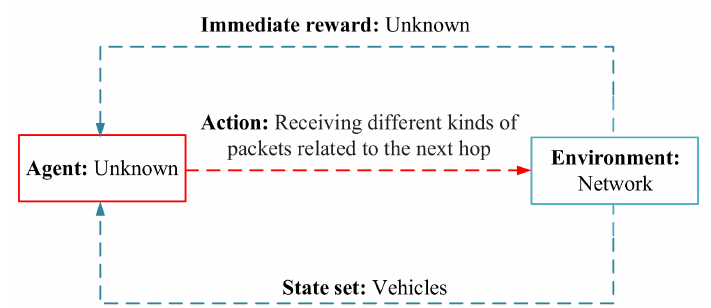
Figure 22. Learning structure learning in RHR.